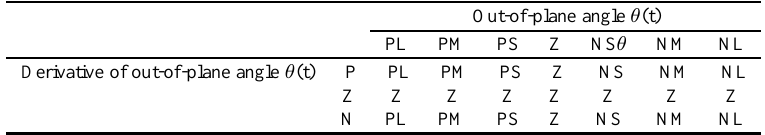
Table 4 The rotational oscillations damping rules